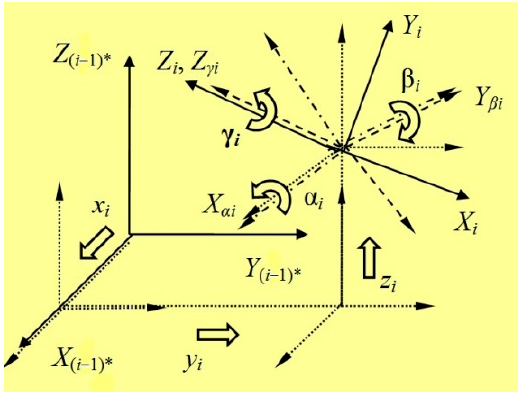
Figure 2. Sequence of coordinate transformations inside the i joint.